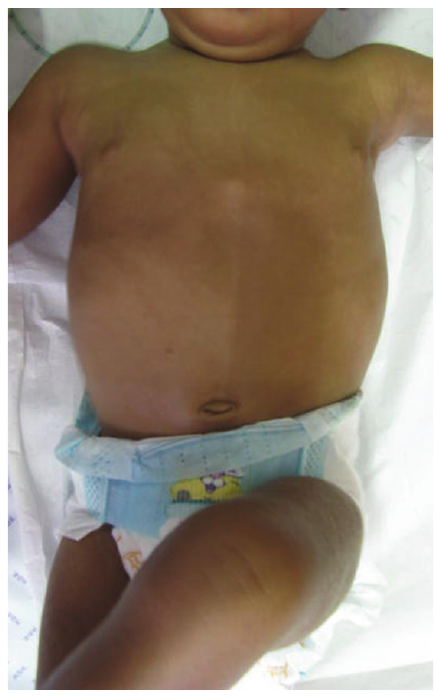
Figure 1: Irregular pattern of hypopigmentation area on the right side of the abdomen, not following the Blaschko